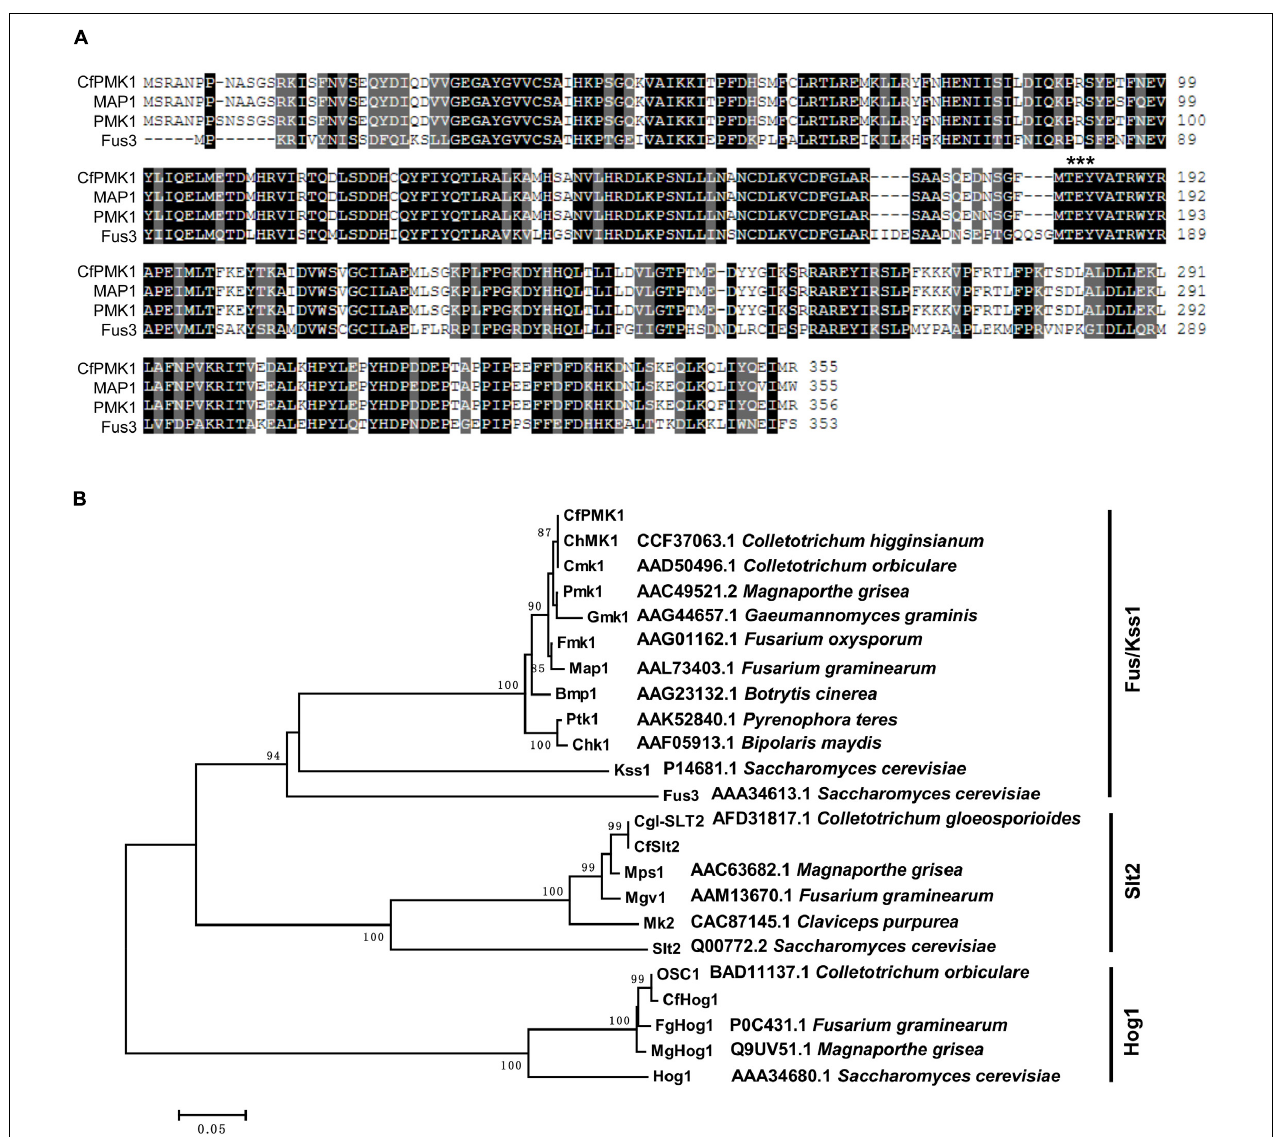
FIGURE 1 | CfPMK1 is a Fus/Kss1 mitogen-activated protein kinase (MAPK). (A) Protein sequence alignment of CfPMK1 and MAP1 from Fusarium graminearum , PMK1 from Magnaporthe grisea , and Fus3 from Saccharomyces cerevisiae . Black background indicates identical amino acid residues and gray background indicates similar residues. The “TGY” motif required for kinase activation is marked by asterisk. (B) Neighbor-joining phylogenetic tree of CfPMK1, CfSlt2, CfHog1, and homologs from other fungi, numbers at nodes are bootstrap values calculated from 1,000 random replications.